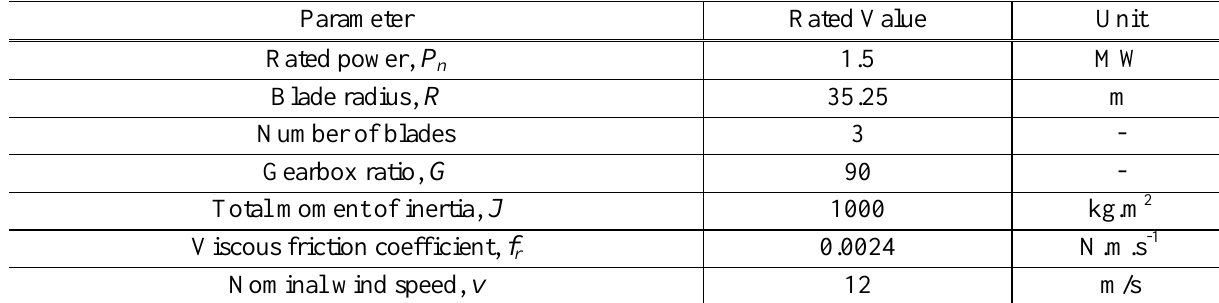
Table 1. Wind turbine parameters